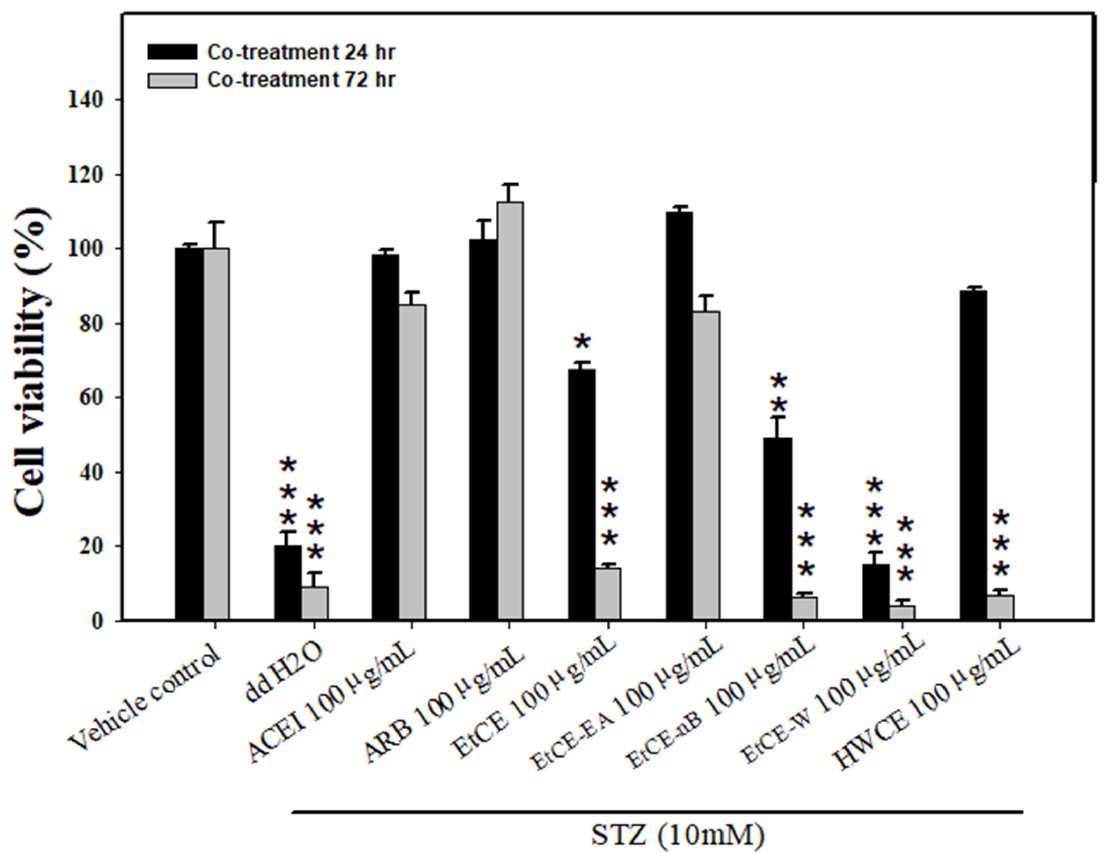
Figure 2. Efficacy of Inonotus obliquus fruit bodies extracts (IOEs) protection from STZ-induced cell toxicity in LLC-PK1 cells. Vehicle control (ddH2O alone), ddH2O, ACEI (100 µ g/mL), ARB (100 µ g/mL), EtCE: Ethanol crude extract of Inonotus obliquus fruit bodies (100 µ g/mL), EtCE-EA: Ethyl acetate layer after water-ethyl acetate separation from ethanol crude extract (100 µ g/mL), EtCE-nB: n-butanol layer after water-n-butanol separation from ethanol crude extract (100 µ g/mL), EtCE-W: water layer after water-n-butanol separation from ethanol crude extract (100 µ g/mL) and HWCE: hot water crude extract of Inonotus obliquus fruit bodies (100 µ g/mL) after 24 h STZ (10 mM) treatment and the protective effects from cytotoxicity were determined by MTT in LLC-PK1 cells at 24 and 72 h. Each value represents the mean ± SD of three replicated experiments, and the results are expressed as population growth. *: p < 0.05, **: p < 0.01 and ***: p < 0.001 as compared with the vehicle